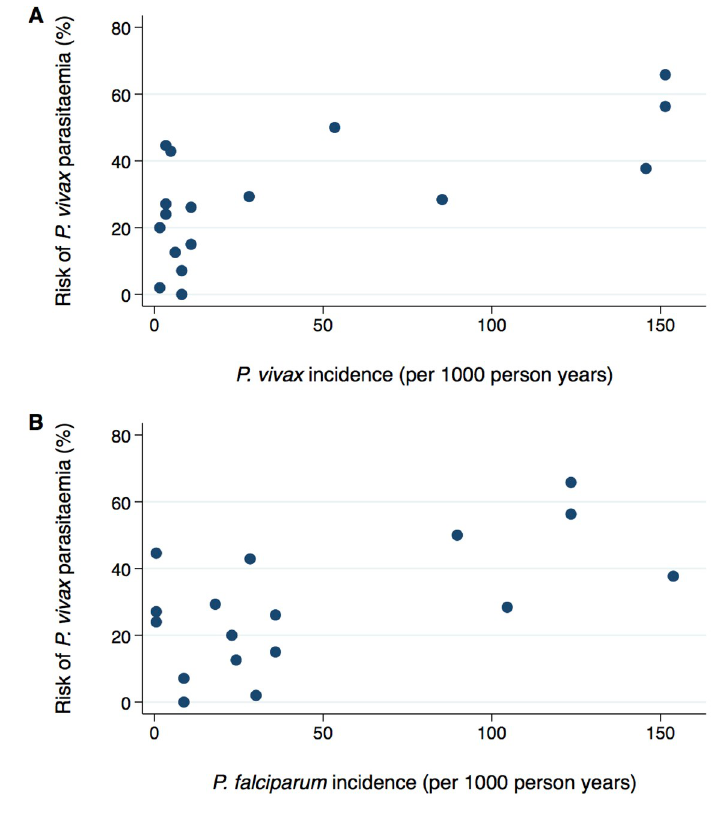
Fig 9. Risk of P . vivax parasitaemia at day 42 following treatment with AL according to background subnational incidence of P . vivax (A) and P . falciparum (B). r s = 0.676, p = 0.0029 (A) and r s = 0.607, p = 0.0098 (B). AL,